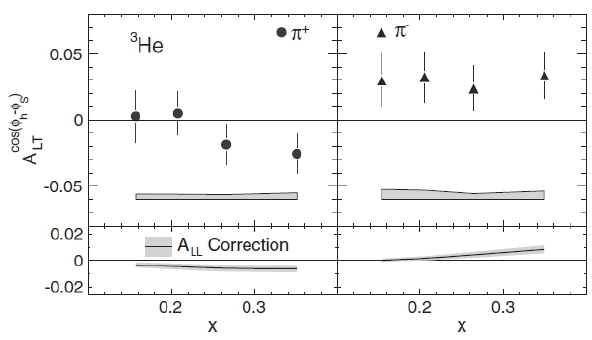
on neutrons show- LT